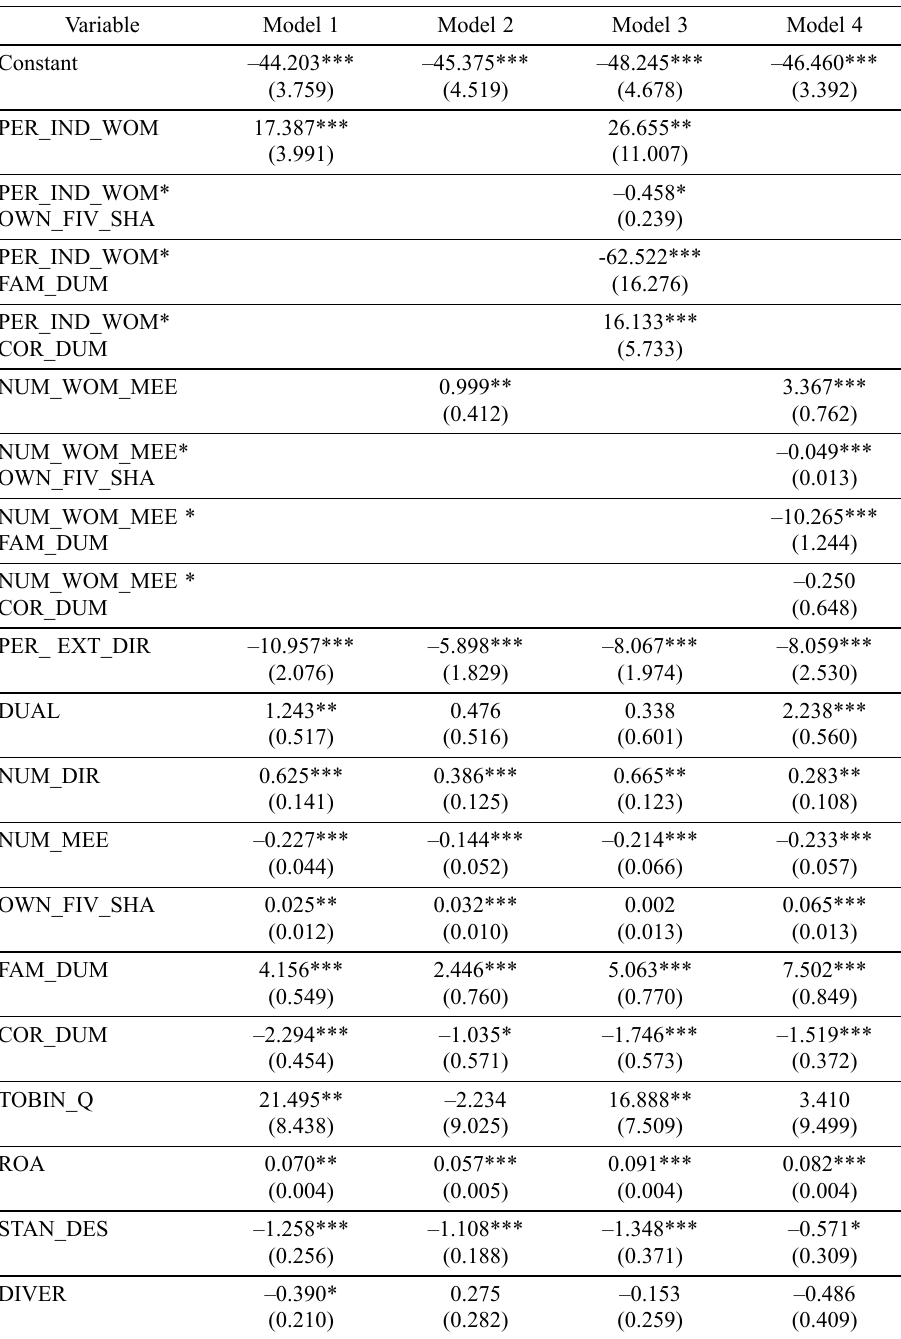
Table 3. System GMM Estimation of the influence of female directors on the logarithm transformation of fraction of variable based